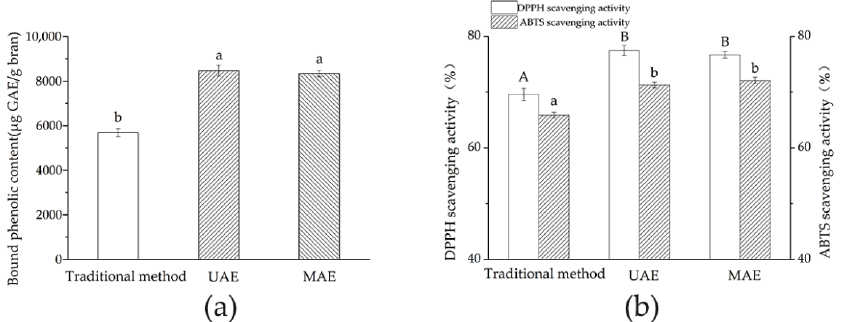
Figure 3. Effect of different treatments on TBPCs ( a ) and antioxidation activity ( b ) of Jizi439 BWB. Values with different lowercase letters indicated statistically significant difference among ( a ) TBPCs or ( b ) ABTS scavenging activities from different treatments ( p < 0.05). Values with different uppercase letters indicated statistically significant difference among ( b ) DPPH scavenging activities from different treatments ( p < 0.05).